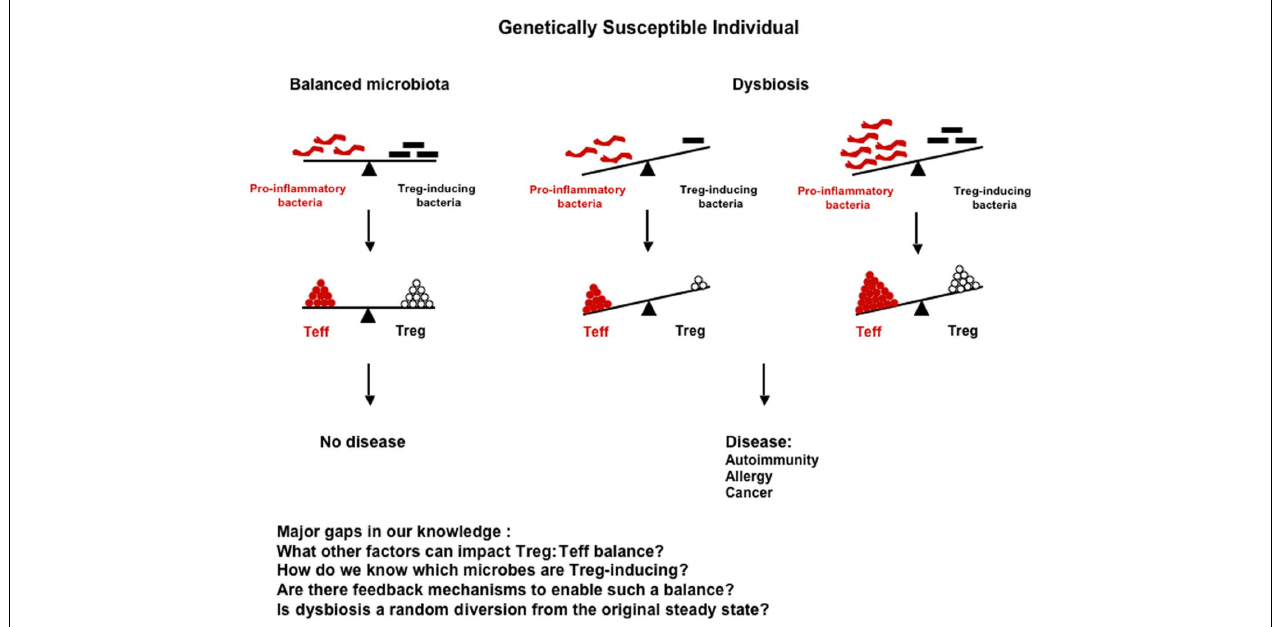
enrichment in pro-inflammatory bacteria (e.g., SFB) that results in increased Teff cells, but unchanged levels ofTregs. In both cases, theTreg:Teff cell balance is biased toward theTeff cells, and the outcome of this imbalance can be development of disease in genetically susceptible individuals.